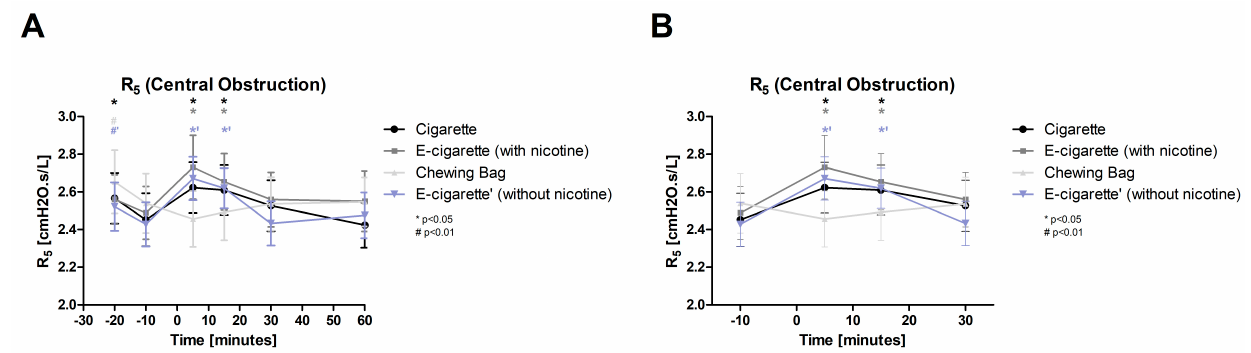
Figure 8. R5 (Central obstruction: ( A ) total follow-up; ( B ) follow-up of expected nicotine half-life). The central obstruction is displayed over time. The first (time 5) and second (time 15) measurements after the intervention Cig, E-Cig (+) and E-Cig (-) show a significant (* p < 0.05) increase. The Chewing bag stays at resting levels.